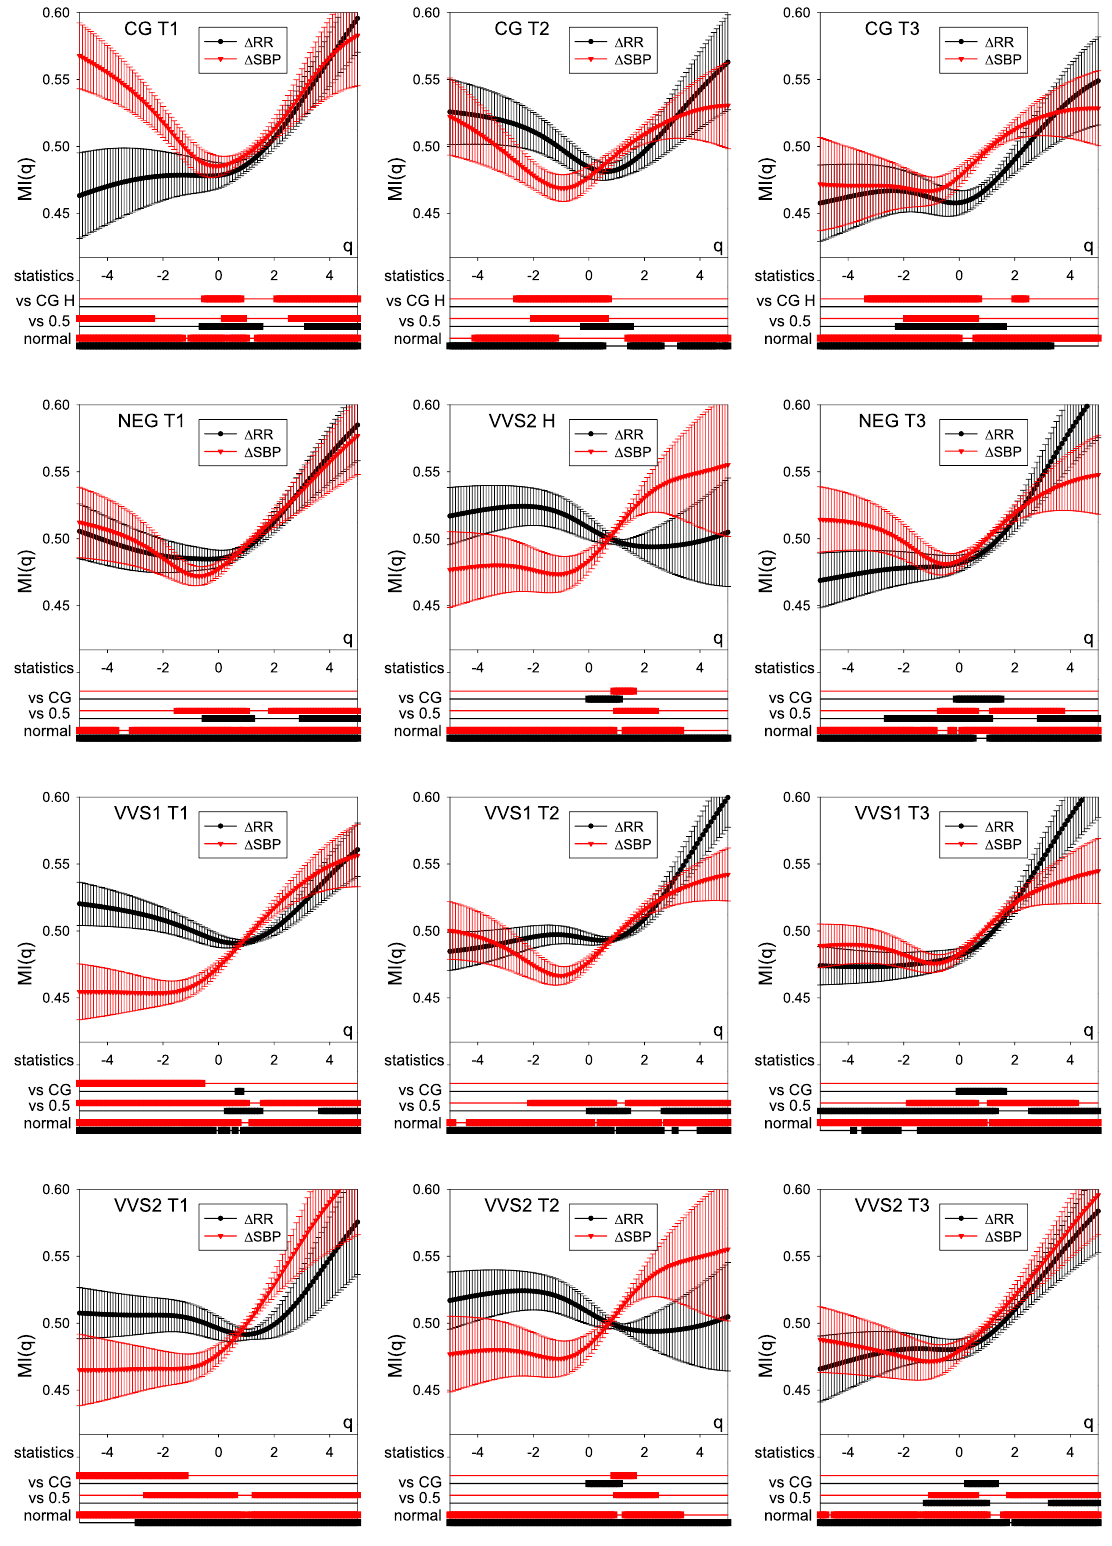
Figure 4. The means MI q ( ) and MI q ( ) and their standard errors obtained for all groups considered in time RR SBP windows after tilting. Below the q -axis, the statistics of the group results are given subsequently: bottom two lines mark q intervals in which the hypothesis of normality cannot be rejected (Lilliefors test, p < 0.05); middle two lines mark q intervals in which MI s are distinct from 0.5 (two-sided t , p < 0.05); top two lines mark q intervals in which MI s are distinct from the corresponding MI s of the CG ( t -test for independent data, p < 0.05). Black curves refer to RR data; red curves describe SBP